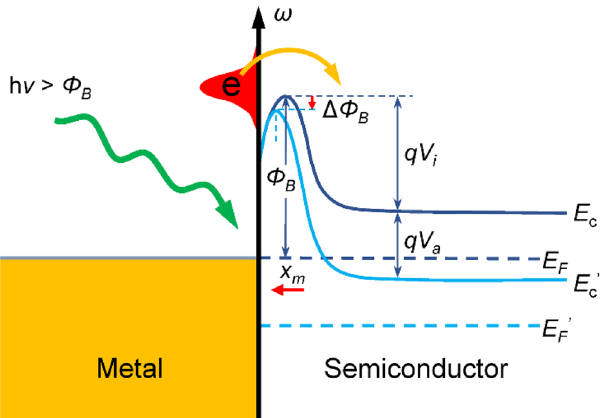
Figure 3. Schematic illustrations of hot-electron generation and energy bands for a Schottky junction without bias (dark blue lines) and under reverse bias (sky blue